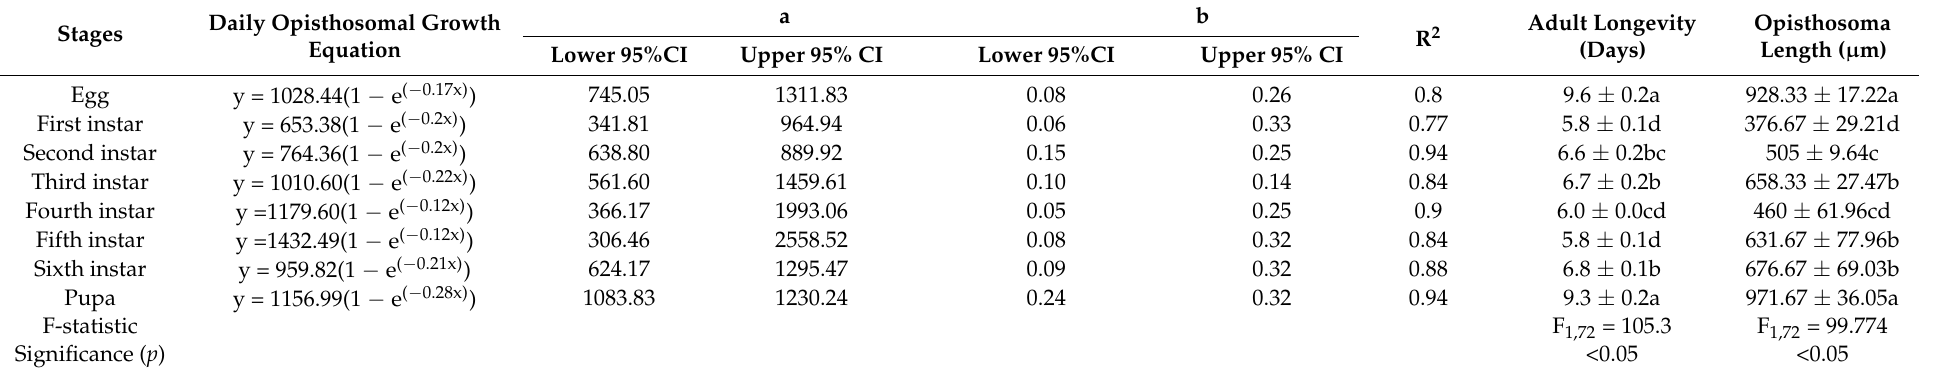
Table 1. Daily growth and development parameters of Pyemotes zhonghuajia on eggs, first to sixth instar larvae, and pupae of Spodoptera litura